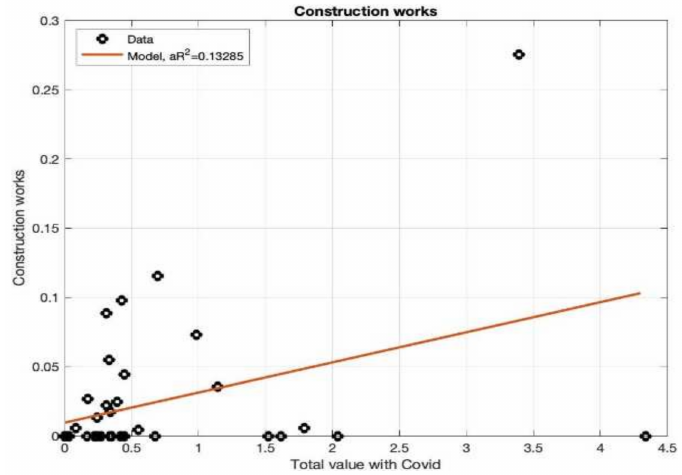
Figure 14. Correlation relationship of total COVID funding vs. construction